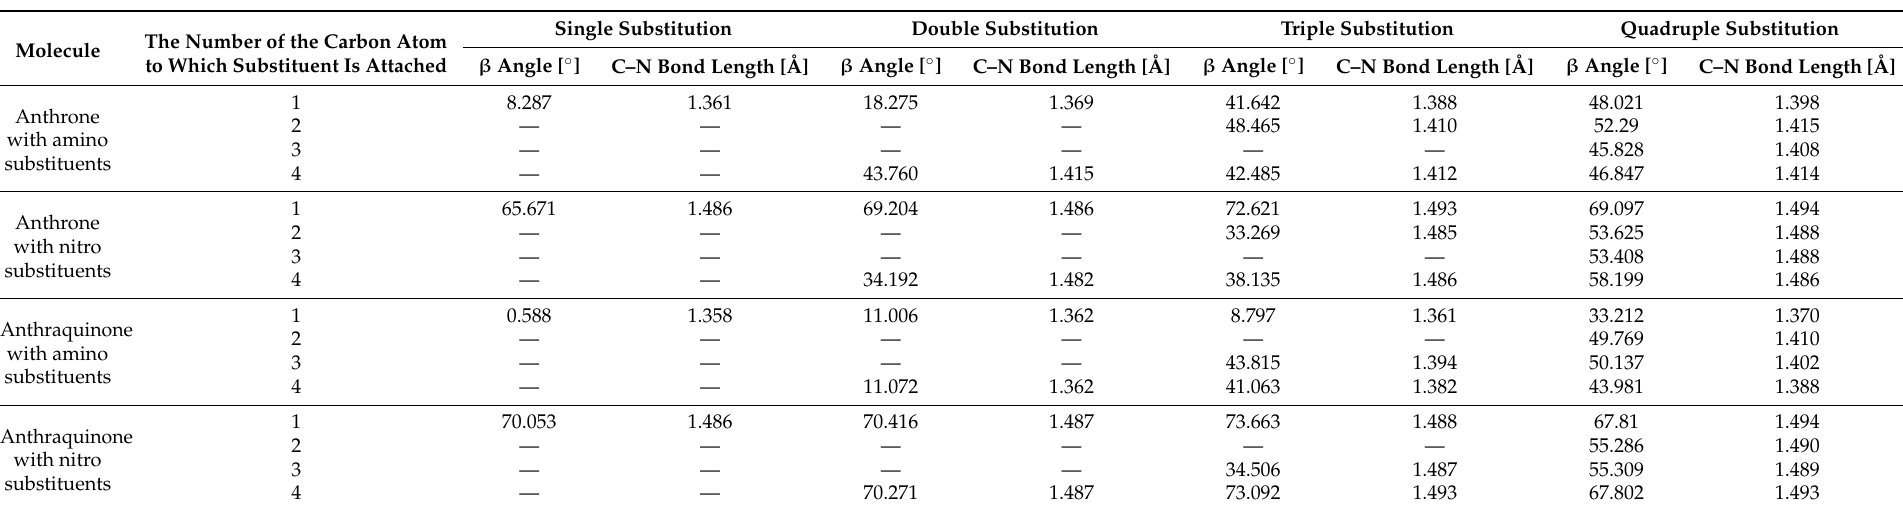
Table 2. β angle and C–N bond length for substituents in the aromatic side